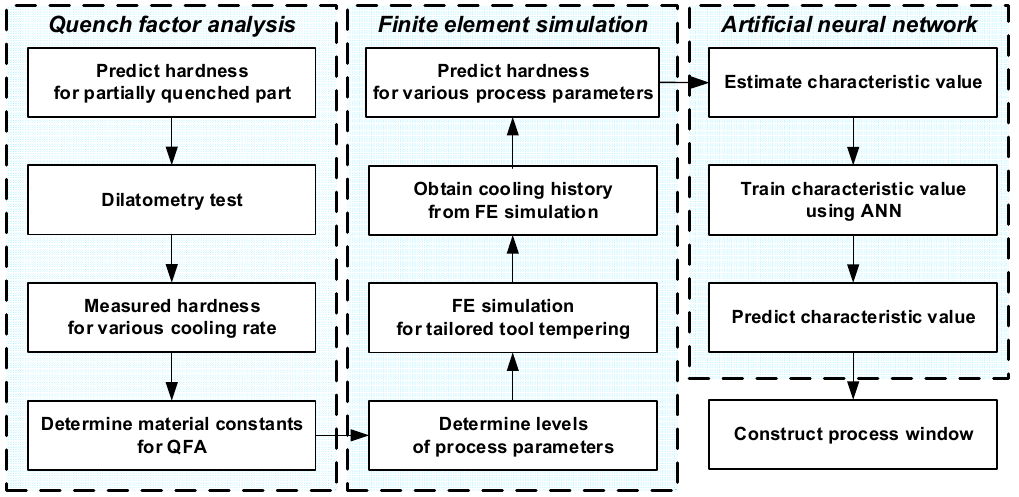
Figure 2. Schematic procedure for construction of process window.